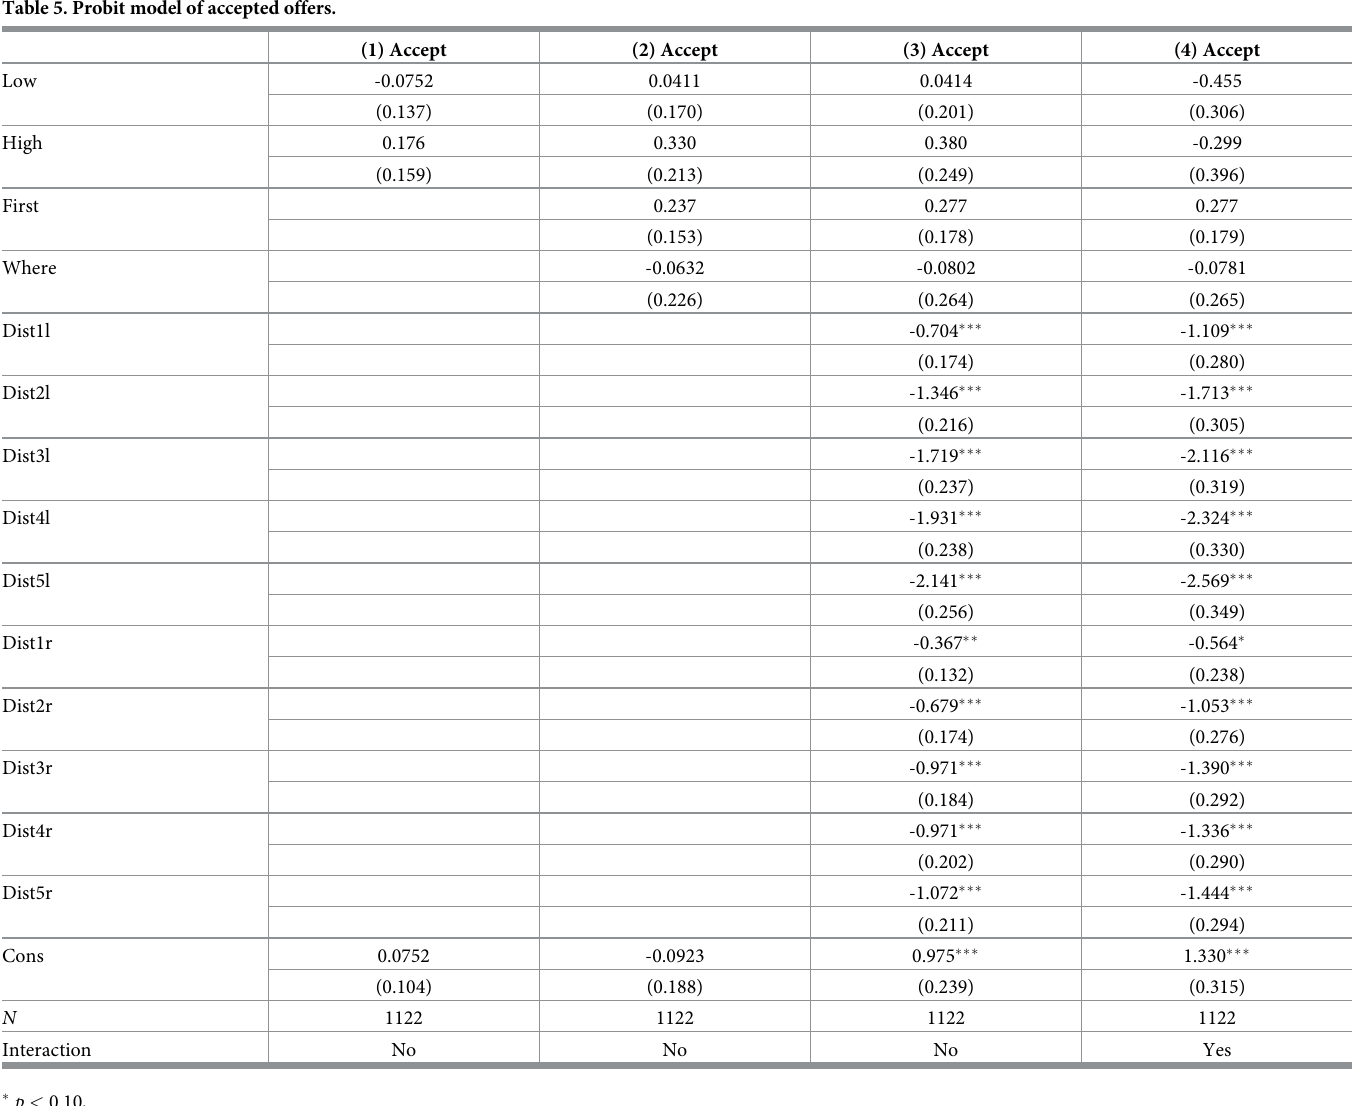
Table 5. Probit model of accepted